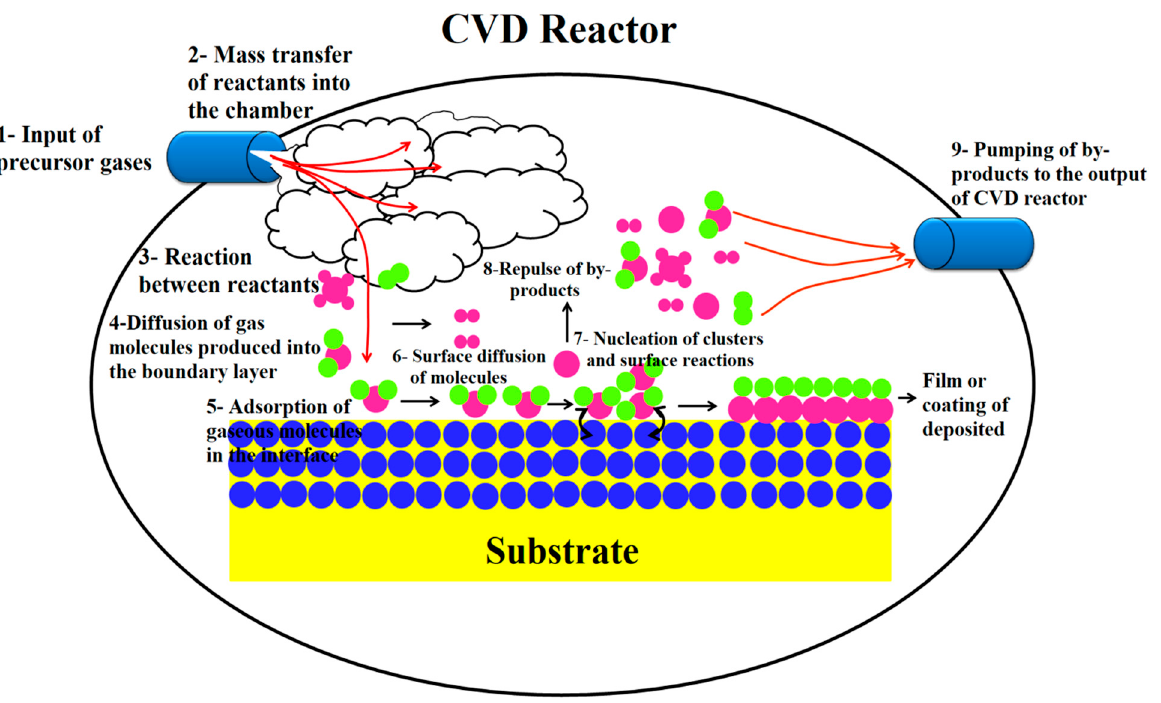
Figure 5. Different steps for deposition of ceramic nanocomposite coatings in the CVD technology.